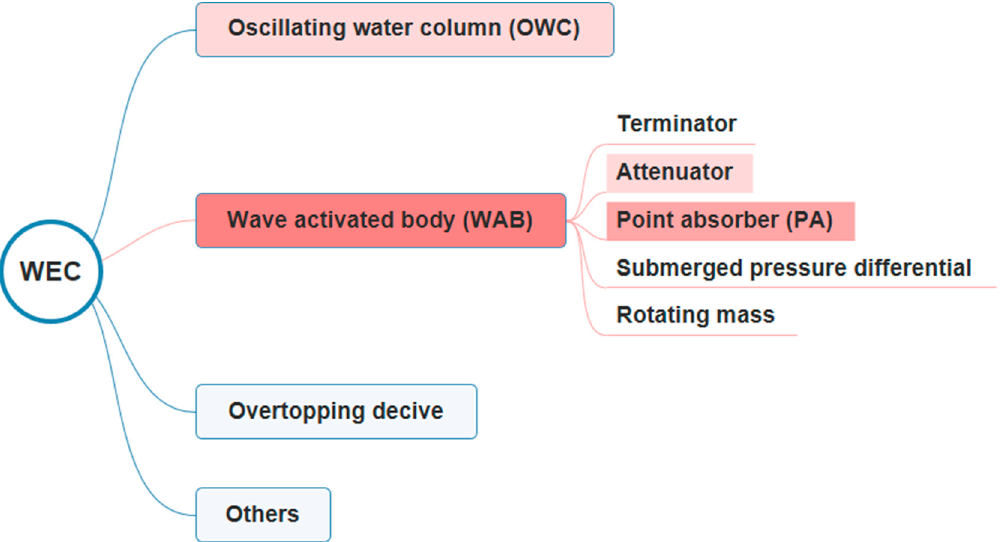
Figure 5. Categories of wave energy converter (WEC) technology. Energies 2019 , 12 , x